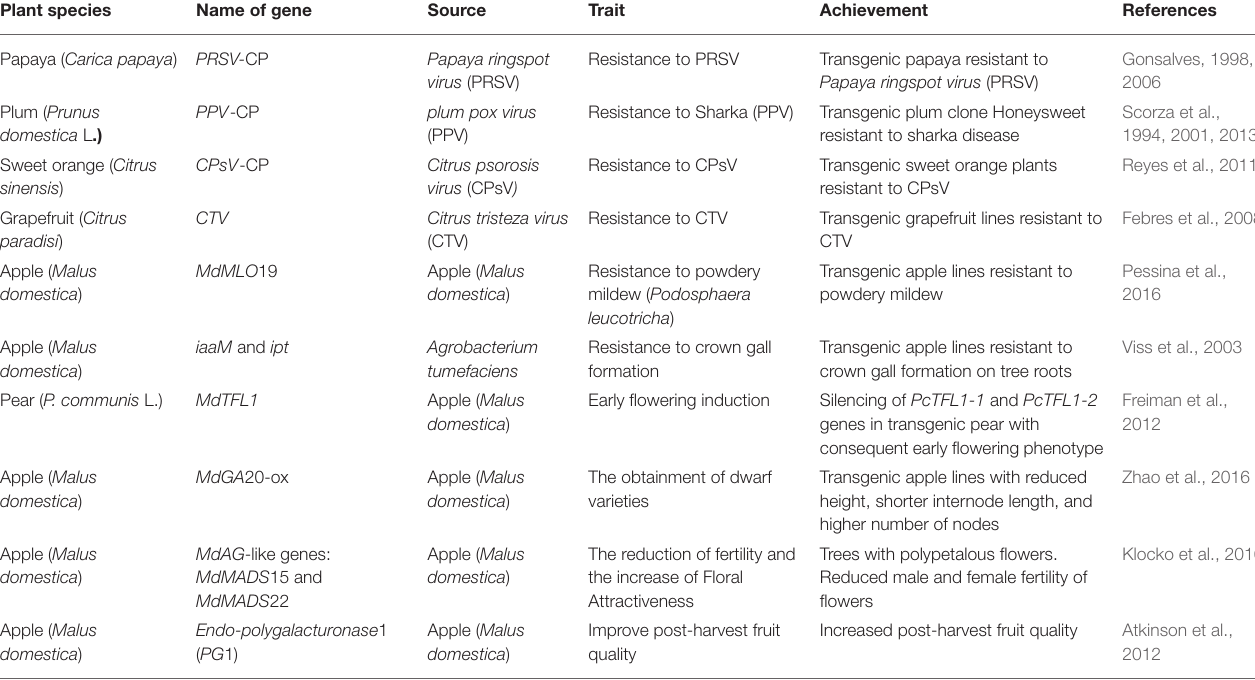
TABLE 2 | Applications of RNA interference in woody fruit species. Plant